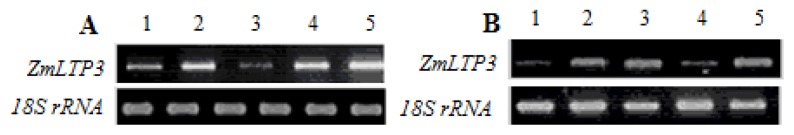
Expression of the ZmLTP3 gene in various tissues and in response to various treatments. (A) Expression of ZmLTP3 in various tissues. 1–5 shows different tissues: (1) roots, (2) coleoptiles, (3) leaves, (4) silks and (5) ovaries; (B) Expression of ZmLTP3 under various treatments: (1) control, (2) mannitol, (3) salt, (4) 4 °C and (5) SA.